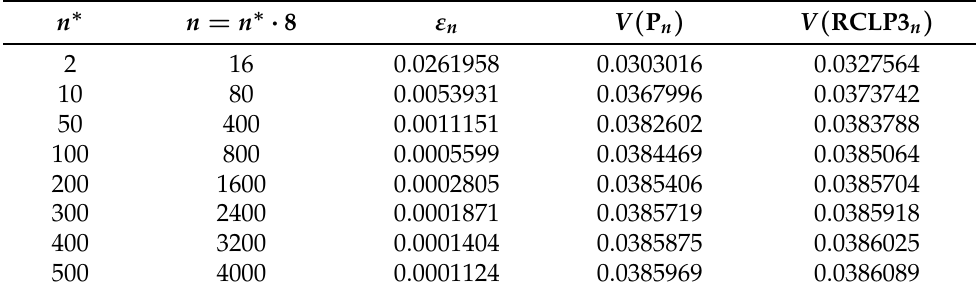
Table 1. Numerical